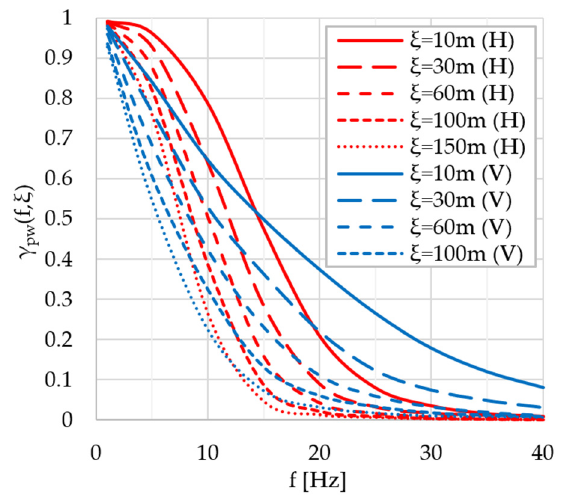
Figure 10. Plane-wave coherency models—Horizontal and vertical components